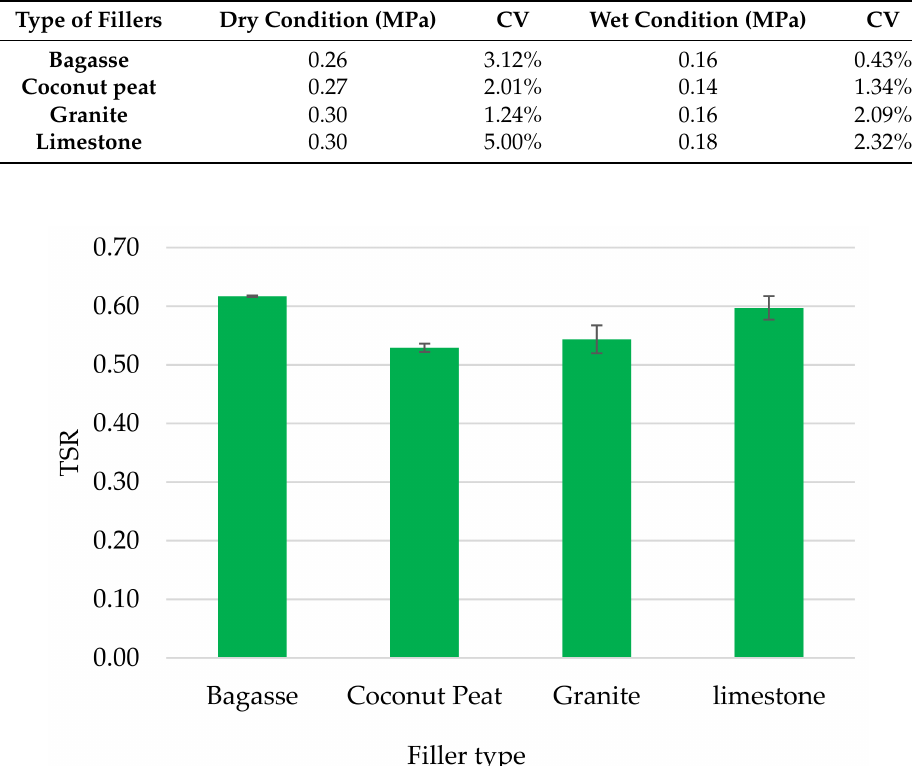
Figure 7. TSR of ITS test after moisture of asphalt mixtures with granite aggregate for all filler types. This indicates that the TSR was dependent on filler type. In this study, results preliminarily confirm that bagasse can be an alternative filler replacing mineral fillers for moisture damage